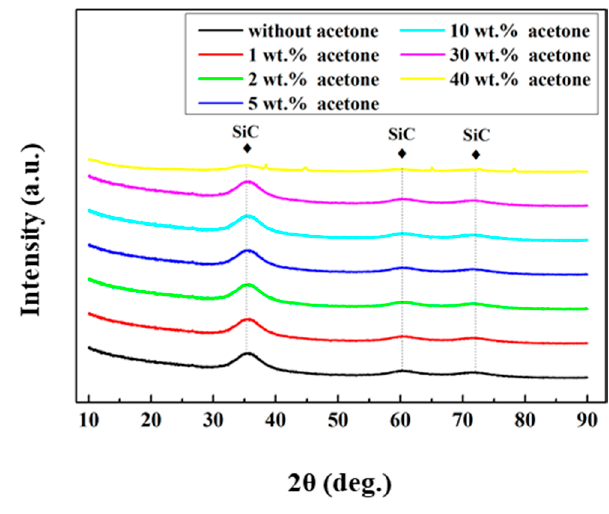
ff erent acetone contents.